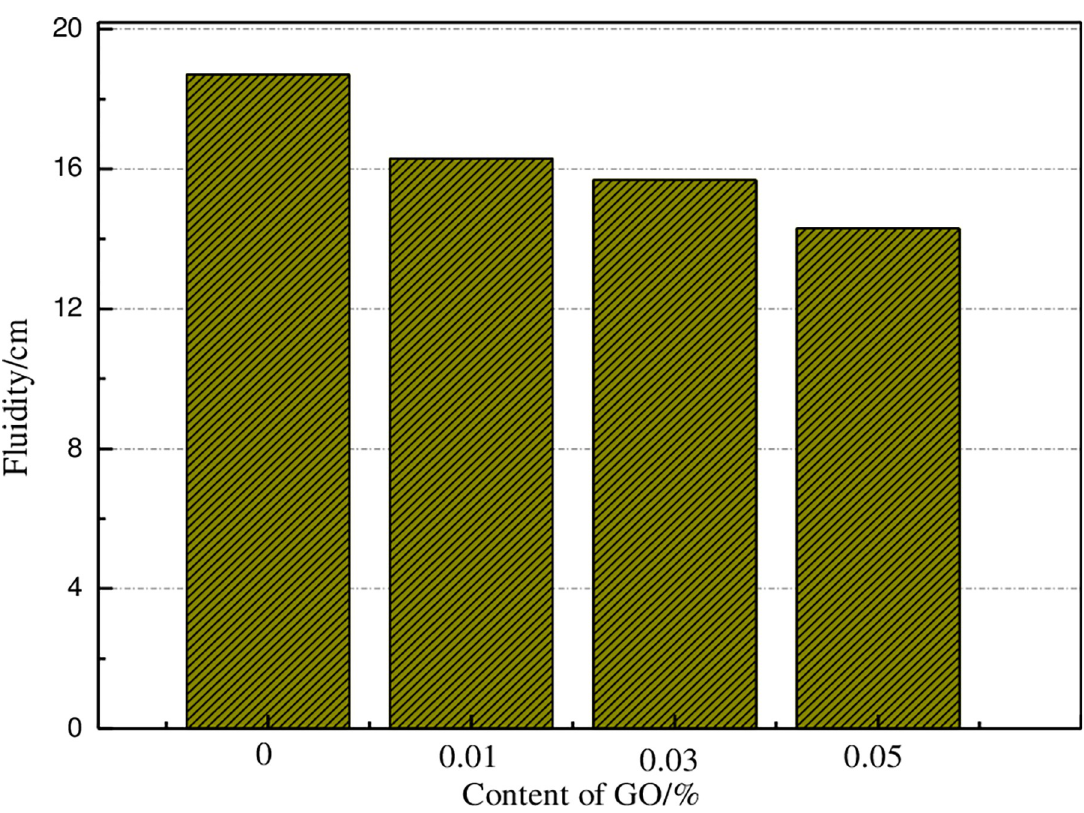
Fig 2. The fluidity of cement slurry under different GO